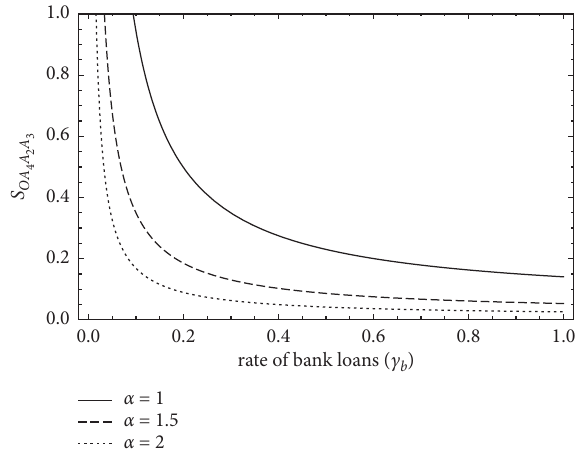
Figure 7: The impacts of the suppliers’ loans on S OA 4 A 2 A 3 with various manufacturers’